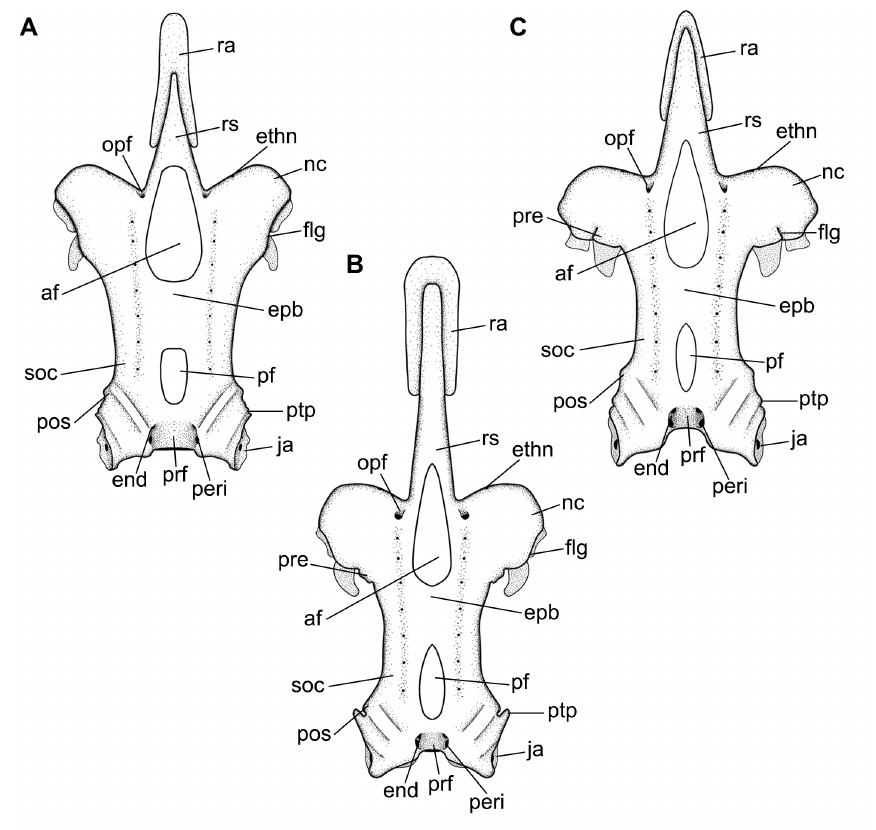
FIGURE 14 | Neurocranium of Atlantoraja species, dorsal view. A , A. castelnaui , UERJ 1853, male, 593 mm TL. B , A. cyclophora , MNRJ 117184, female, 583 mm TL. C , A. platana , UERJ 1383, male, 372 mm TL. af , anterior fontanelle; end , endolymphatic foramen; epb , epiphysial bridge; ethn , foramen for the passage of the ethmoidal nerve; flg , flange; ja , jugal arch; nc , nasal capsule; opf, ophthalmic foramen; peri , perilymphatic foramen; pf , posterior fontanelle; pos , postorbital process; pre , preorbital process; prf , parietal fossa; ptp , pterotic process; ra , rostral appendix; rs , rostrum; soc , supraorbital